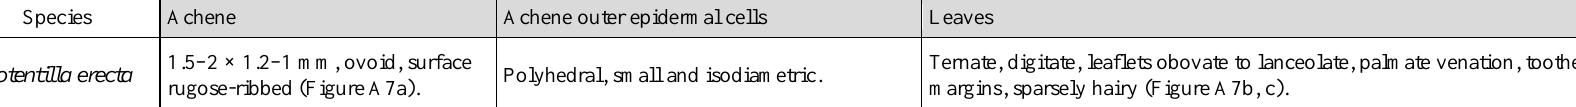
Polyhedral, small and isodiametric.